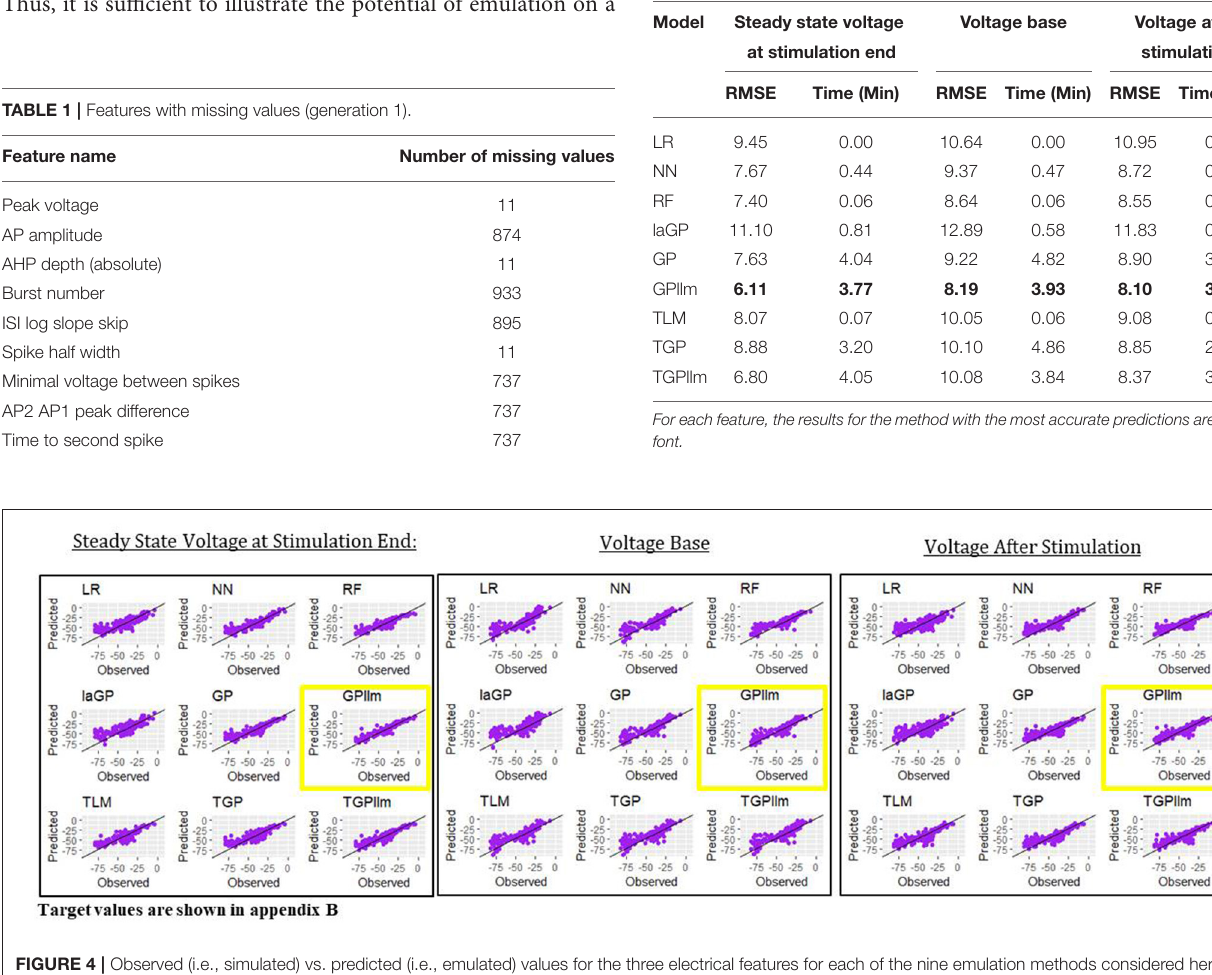
Frontiers in Big Data |